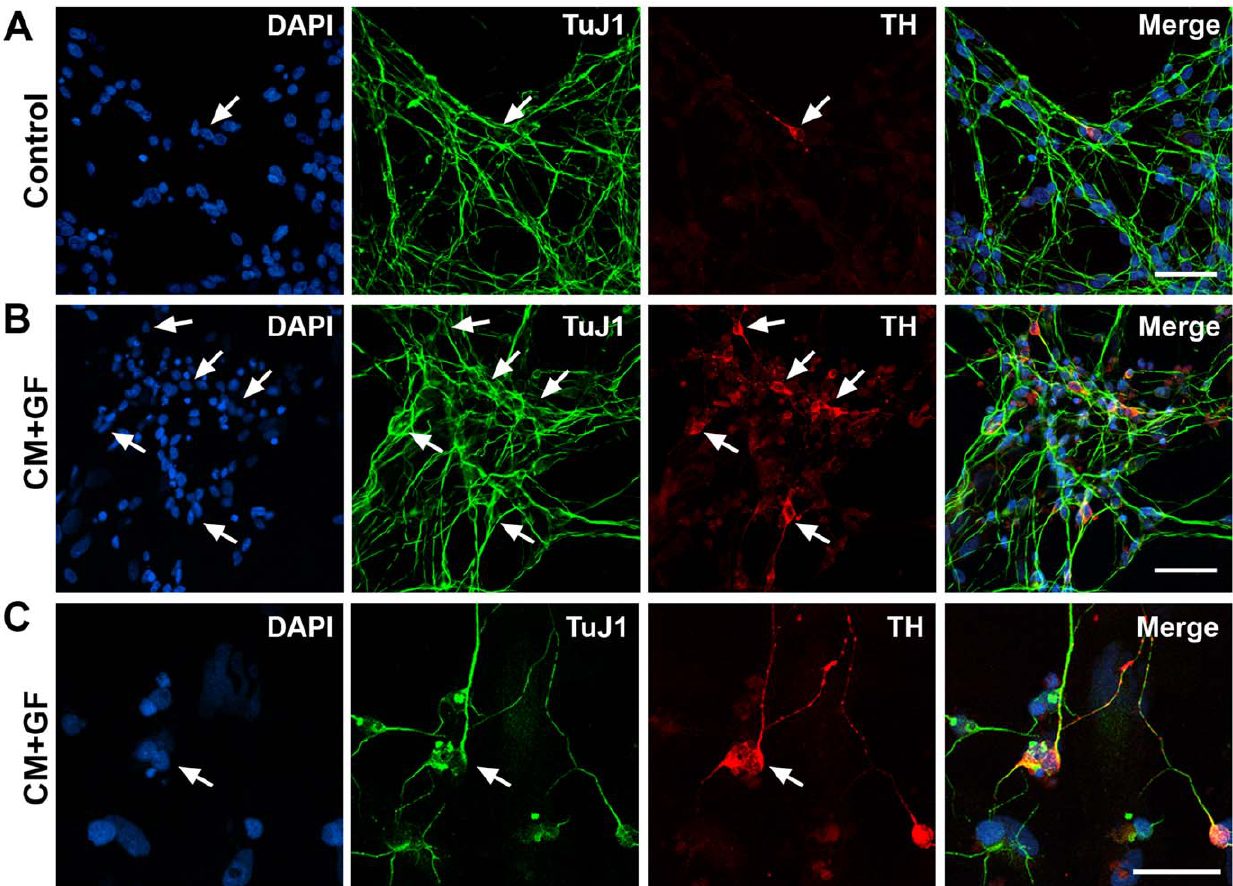
Figure 2. Treatment with the glial conditioned media (CM) and growth factors (GF) induce TH expression in hNSCs derived from hESCs. hNSCs were single cell dissociated in a defined medium and plated on poly-L-ornithine-coated glass coverslips either under control conditions (A) or in glial cell line conditioned media supplemented with the growth factors bFGF (20 ng/ml) and LIF 10 ng/ml for 10 days (B & C). Fixed cultures were stained with nuclear marker DAPI (blue) and processed for TH (red) and for the neuronal marker TuJ1 (green) immunocytochemistry, as described in Materials and Methods. Scale bars are 50 m m (A–C).